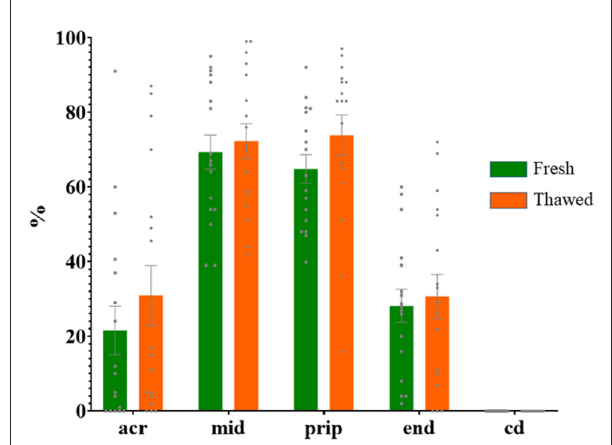
FIGURE5 Proportion (mean ± SEM) of fresh and frozen-thawed spermatozoa from ejaculates classified as of poor freezability (PFE) with representative localization patterns of AQP3 in membrane domains. Acr, Acrosome; mid, midpiece; prip, principal piece; end, end piece; cd, cytoplasmic